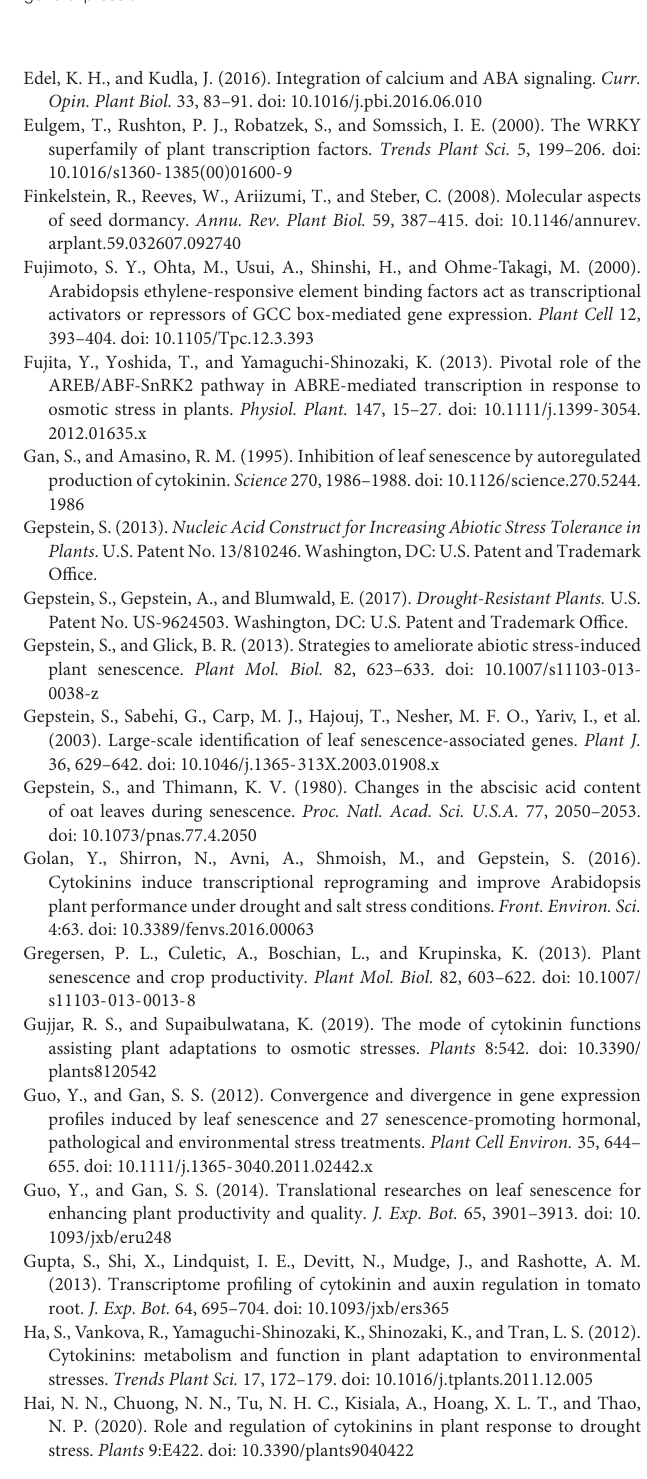
The metallothionein promoter nucleotides 1–1300 (blue letters); the IPT coding sequence nucleotides 1301–2100 (black letters); and the NOS terminator nucleotide 2101–2334 (red letters)(Gepstein, 2013). GenBank accession number MN862698. FIGURE S2 | Nucleotide sequence of metallothionein (MT) promoter. Highlight regions correspond to (1) MYC recognition sites (green); (2) ARR1 binding